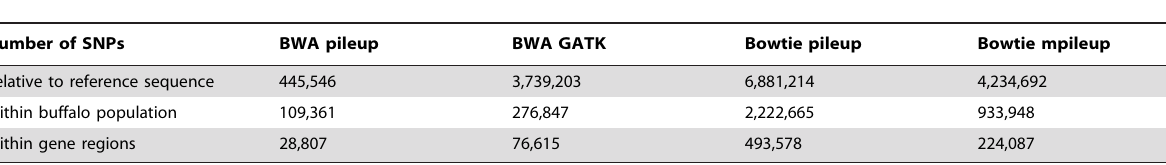
Table 1. Comparison of SNPs identified after mapping with BWA and Bowtie.